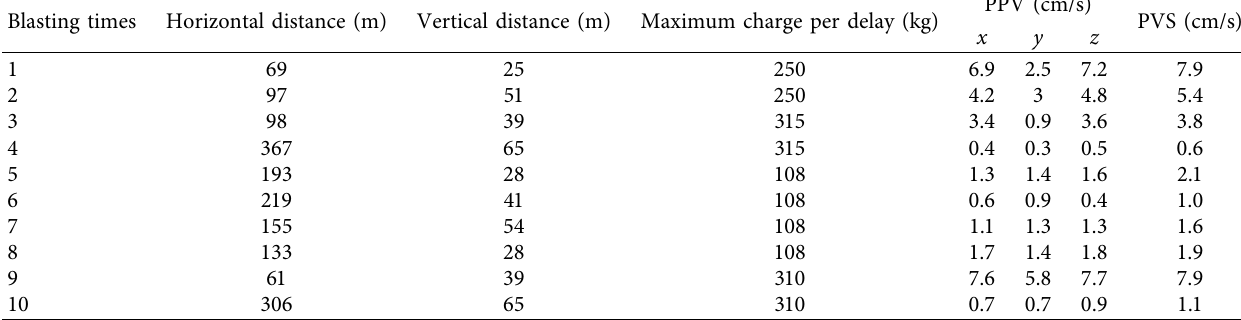
Table 3: Monitoring data on the slope surface.